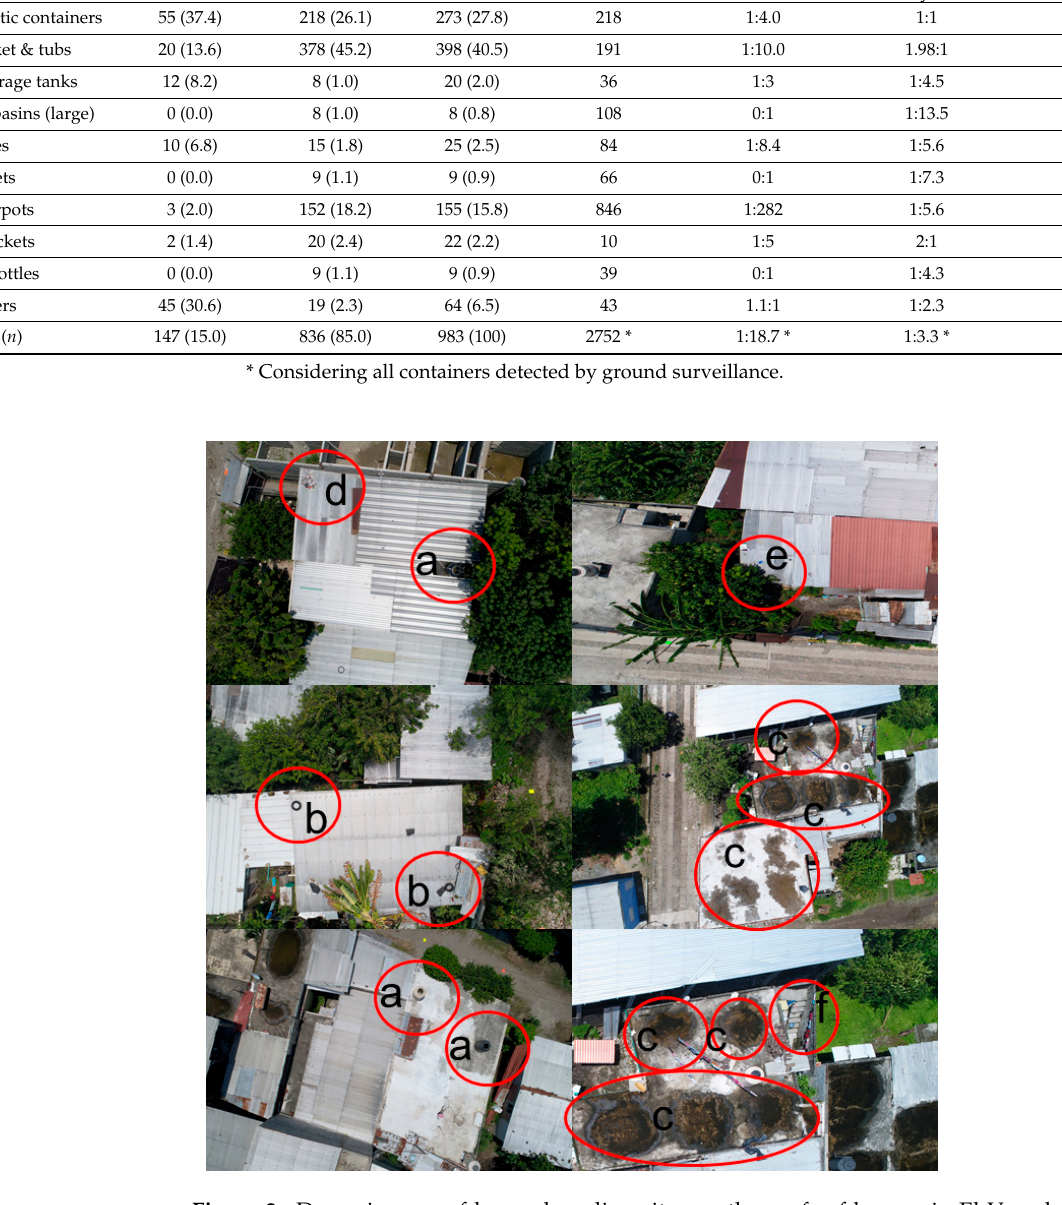
Figure 2. Drone images of larvae breeding sites on the roofs of houses in El Vergel, Tapachula, Chiapas, in ( a ) elevated storage tank; ( b ) tires; ( c ) others (puddles); ( d ) disposable plastic containers, ( e ) flowerpots and ( f ) plastic bucket & tubs.